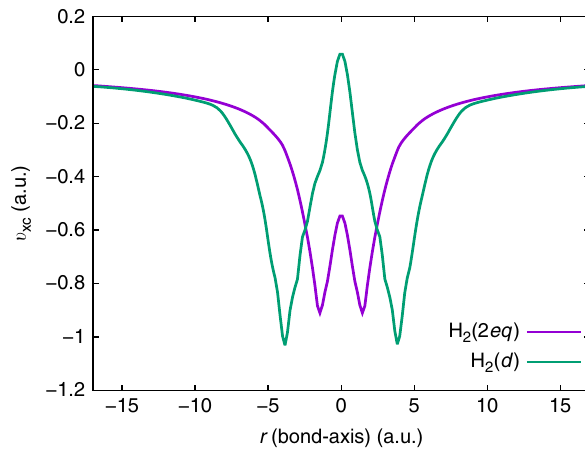
) for equilibrium H 2 . A for stretched H 2 molecules. The exact v Fig. 6 Exact v xc xc potential. two stretched hydrogen molecules: one at twice the equilibrium bond xc length ( H 2 ð 2 eq Þ ) and the other at dissociation ( H 2 ð d Þ ). The H atoms ) and GGA ( exact (cid:3) Δ ρ ) LDA GGA